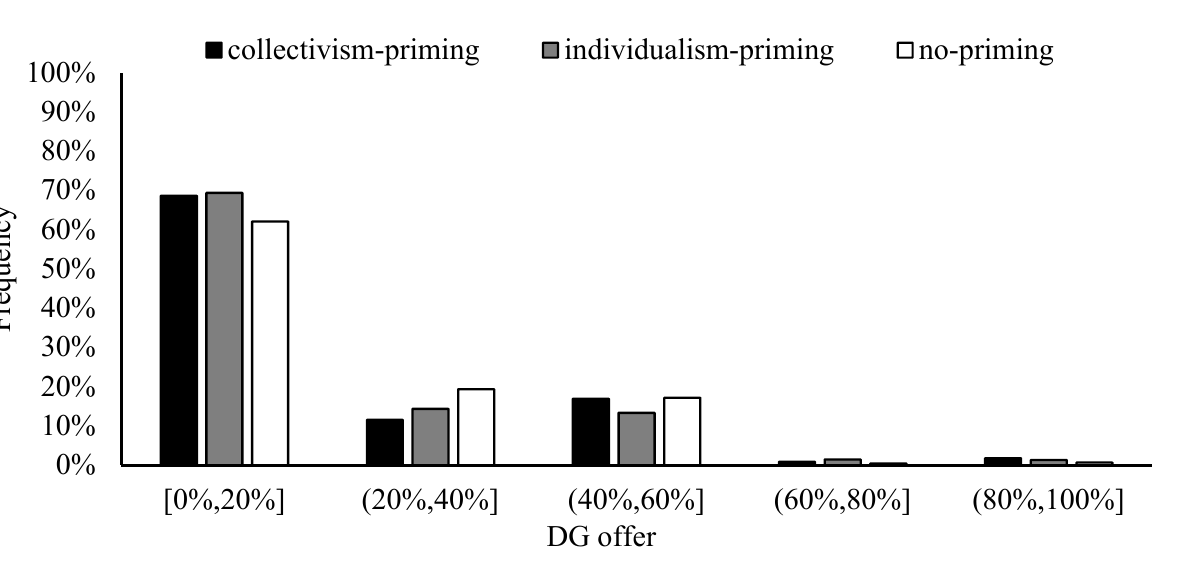
Figure 3. Frequency of DG offers.